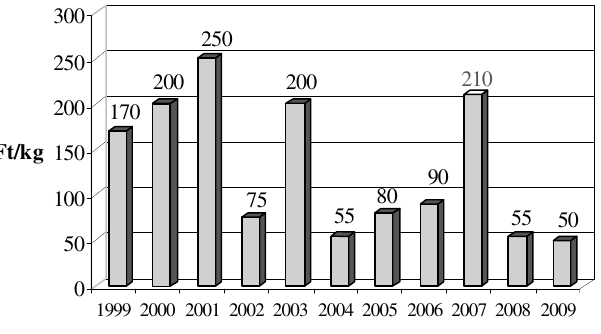
Figure 1: Variation of the producer’s prices paid by the processing industry during the period